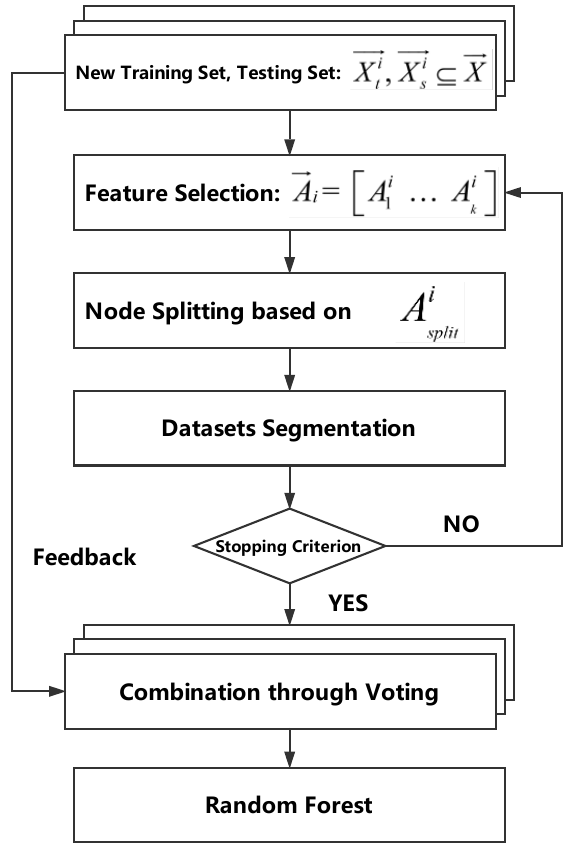
Figure 7. Technical details in Random Forest